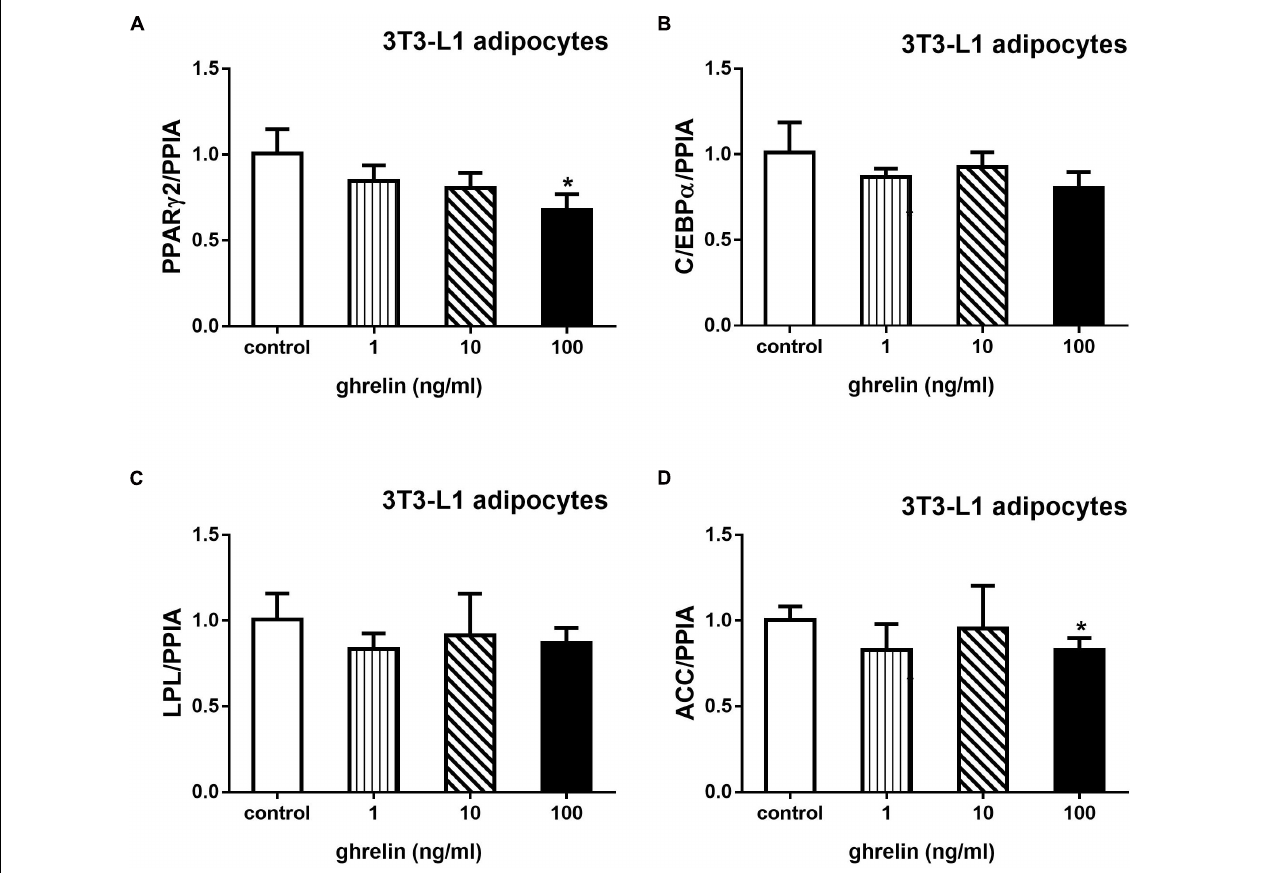
FIGURE 8 | Ghrelin downregulated the expression of PPAR γ 2 and ACC mRNA in 3T3-L1 differentiating adipocytes. The mRNA levels of PPAR γ 2 (A) , C/EBP α (B) , LPL (C) , and ACC (D) were determined by determined by RT-qPCR analysis. The data are presented as the mean ± SD for three independent experiments with three wells in each experiment. ∗ p < 0.05 vs. 0 ng/ml ghrelin